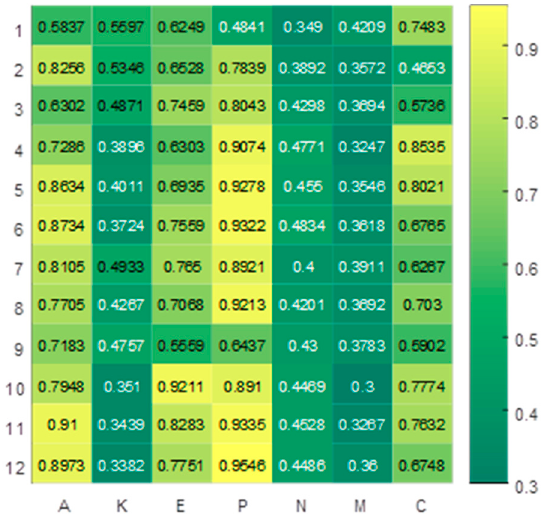
Figure 3. Heat map illustrating the predictive performance (AUC) of the relationship between cancer features and importance degree in patients. P: Primary tumor control was the most important degree in patients.